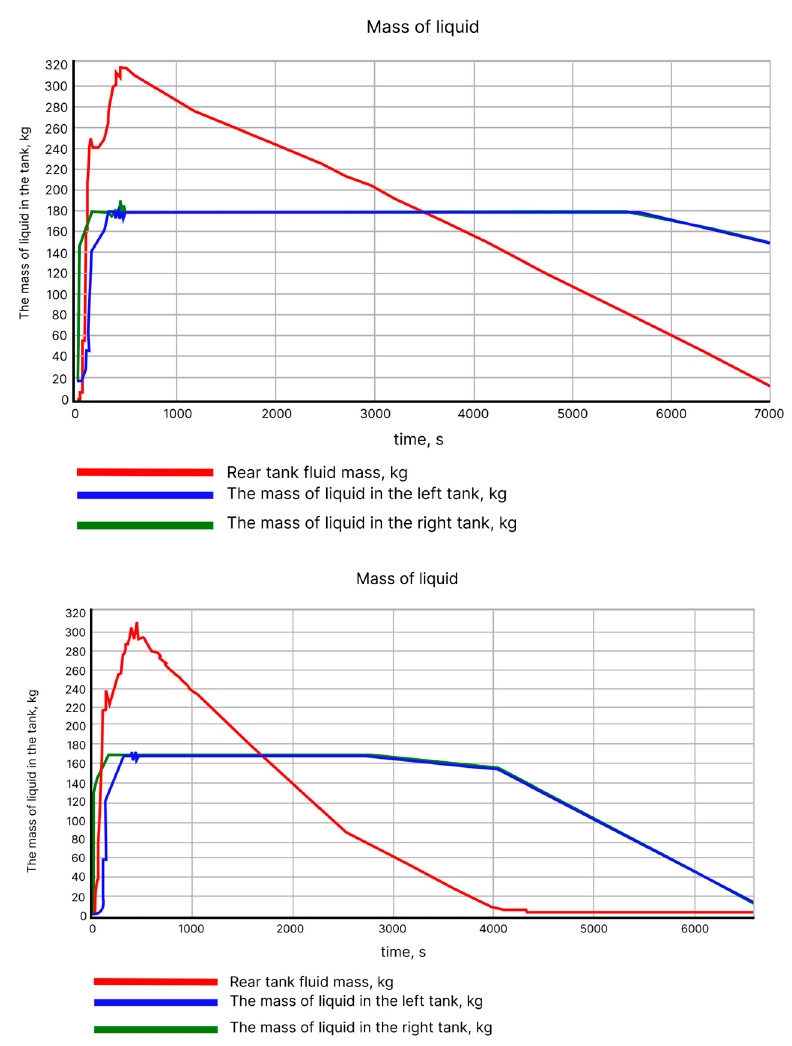
Figure 7. Fuel mass in tanks depending on operating time at varying engine consumption.